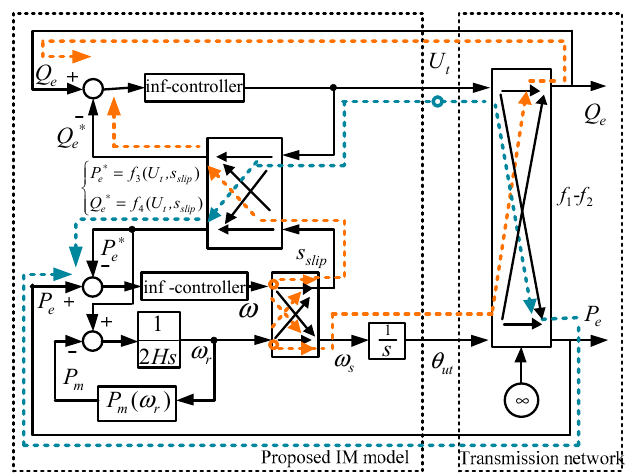
Figure 6. System dynamic analysis block diagram for a single-IM infinite-bus system.